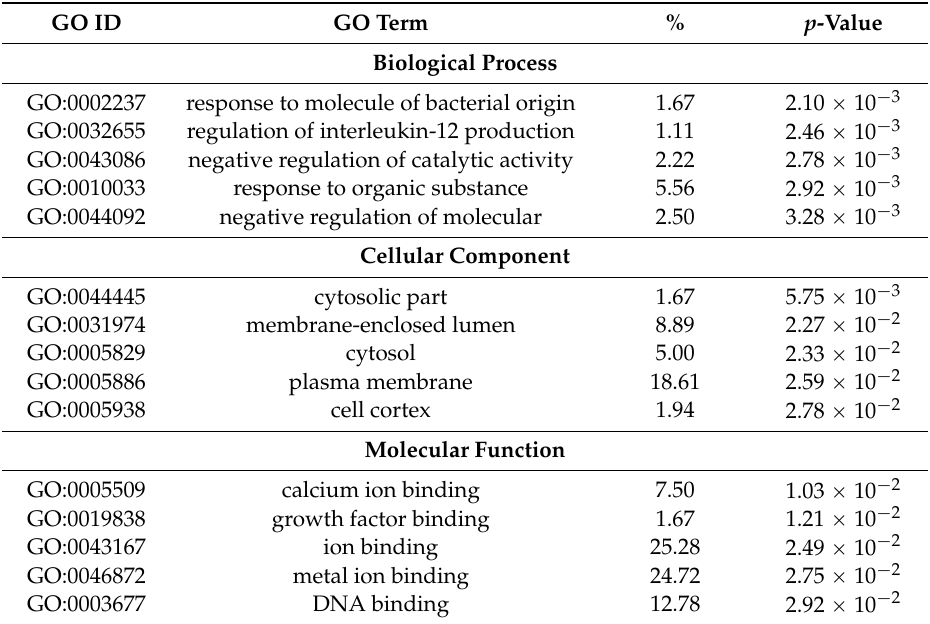
Table 2. Gene ontology (GO) functional annotation for differentially expression genes in Mus musculus (Top